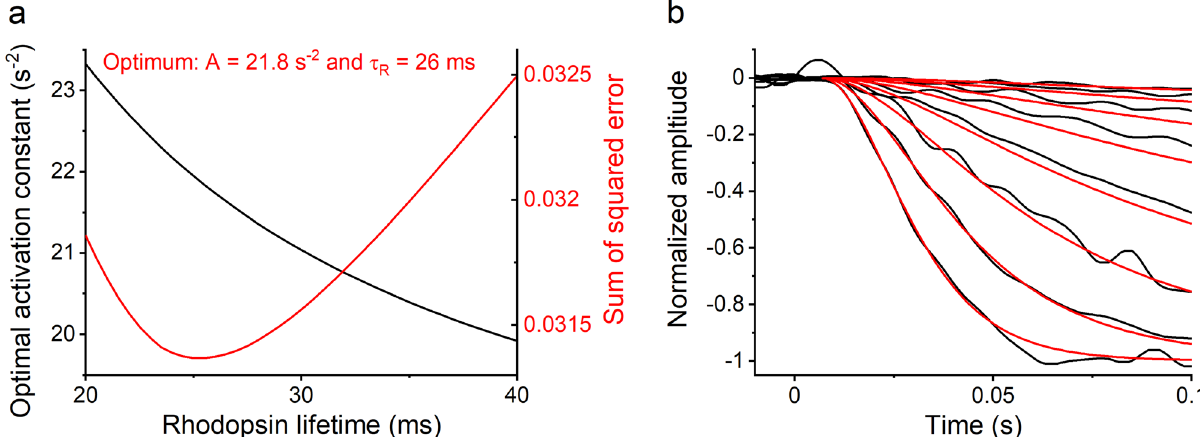
Figure 2. Determination of rhodopsin lifetime and phototransduction amplification constant by fitting the flash response model to the response leading edge (Eq. (15)) to the activation phase of the population-averaged LERG-OS response family recorded in low Ca 2+ solution with twofold increments in flash strengths. ( a ) The outcome of fitting the model with different τ R values to the response family. The black curve shows the optimal amplification constants leading to the best fit with different τ R values, and the red curve shows the sum of squared errors of the fits. The combination of τ R and A values leading to the overall best fit (lowest sum of squared error, the minimum of the red curve) of the model was τ R = 26 ms and A = 21.8 s −2 . ( b ) A population- averaged response family in low Ca 2+ (n = 13) and the model fittings using τ R = 26 ms and A = 21.8 s −2 . Response families were recorded with flash strengths ranging from 1.4 to 177 R*rod −1 . The model was fitted to all responses up to the first saturated